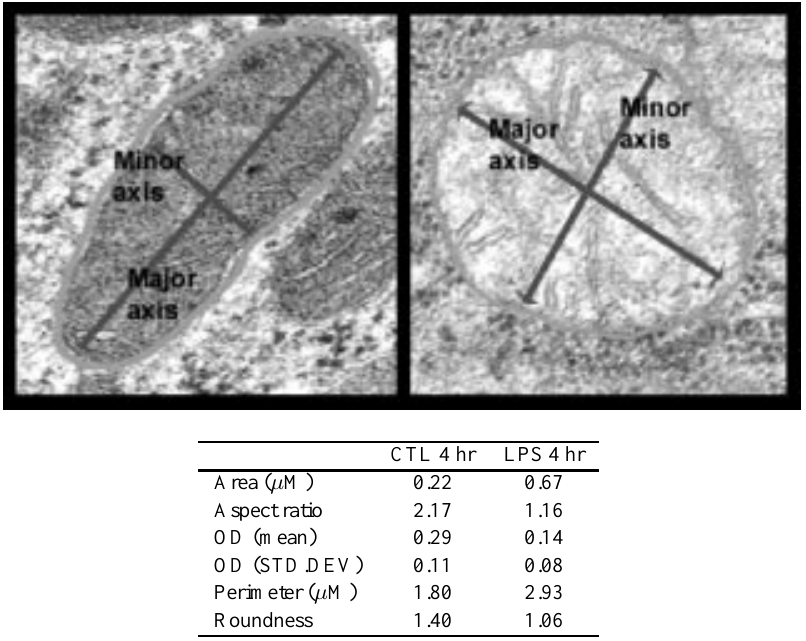
Fig. 2. Representative of digital imaging parameters for individual mitochondria 4 hours after the administration of vehicle control (left panel) or LPS (right panel). Digital parameters of area and perimeter were derived from a continuous tracing of the outer mitochondrial membrane (green line). The aspect ratio and roundness of individual mitochondria were determined using the major and minor axes (red lines), as shown. The optic density (OD) parameters were measured within the region described by the perimeter (green line) and likely reflect changes in the density of the mitochondrial matrix (e.g., a decrease in OD may occur during osmotic swelling).